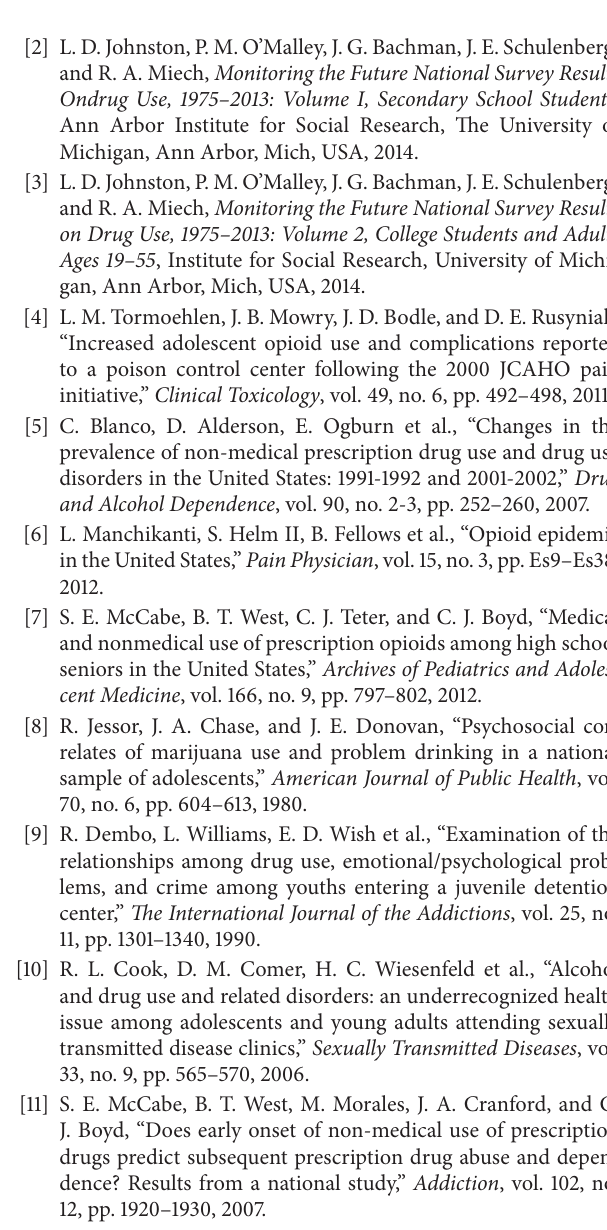
1 Symptom Checklist-90, Global Severity Index.